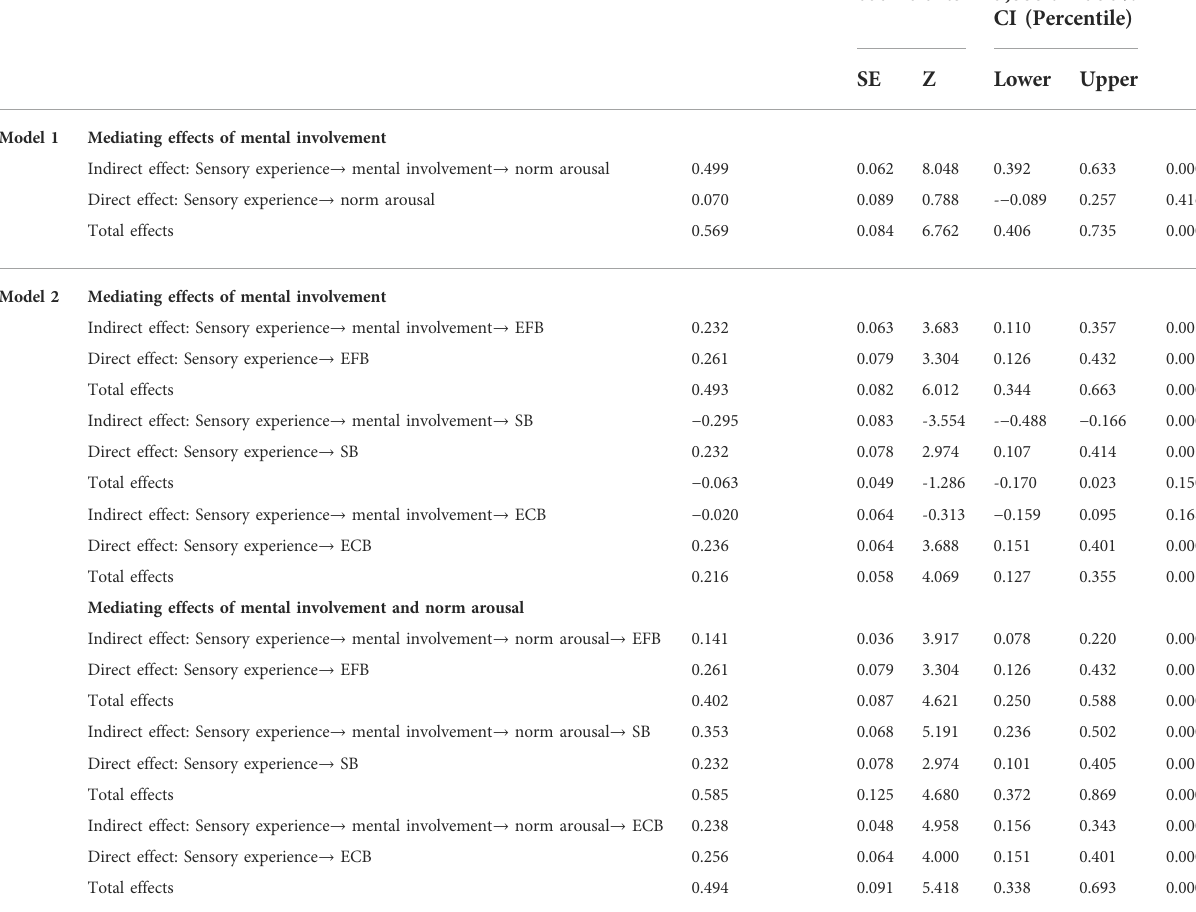
TABLE 4 Mediating effects of mental involvement and norm arousal in Models 1 and 2